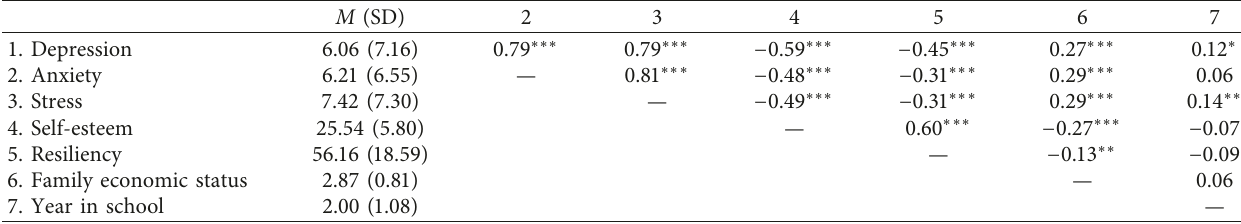
Table 1: Means, standard deviations, and correlations of measured variables.